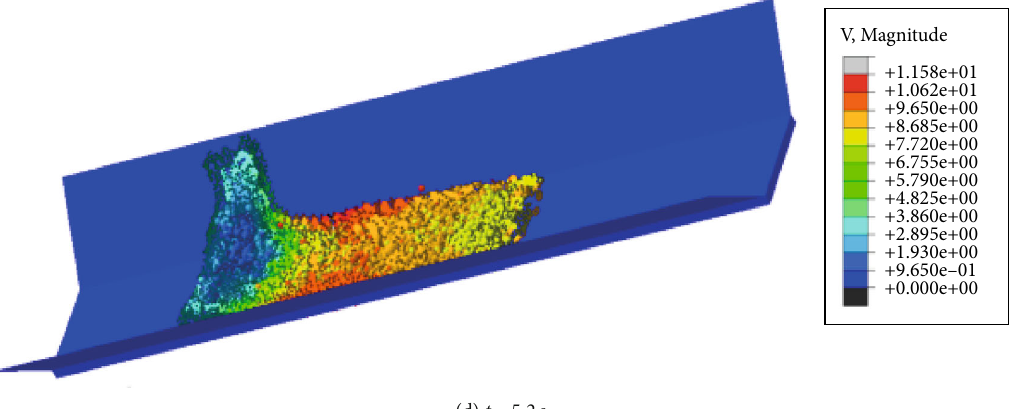
Figure 6: Climbing and silting process of debris fl ow.